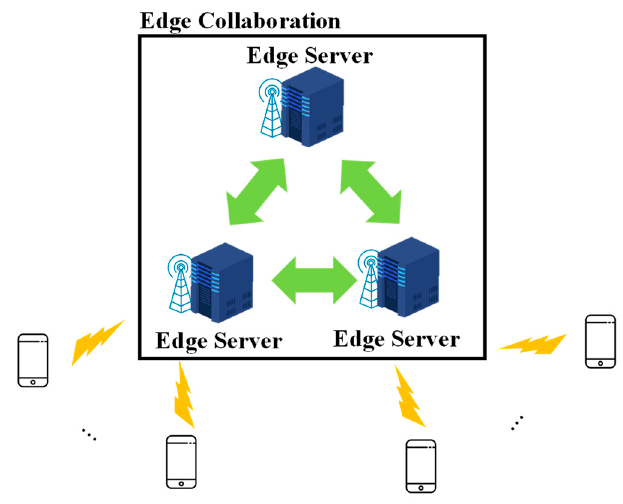
Figure 1. Edge collaborative network environment.